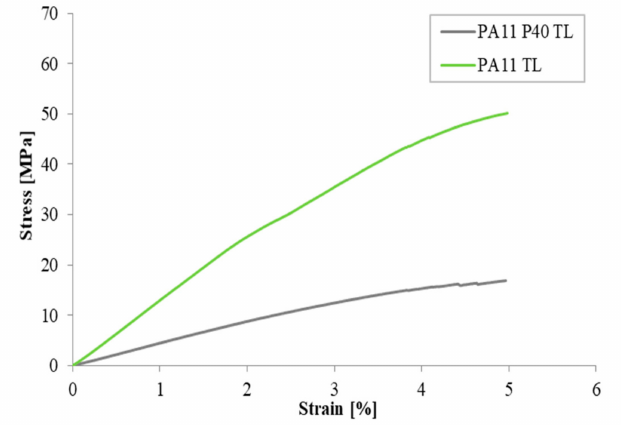
Figure 4. Representative flexural stress-strain curves of PA11 matrices.